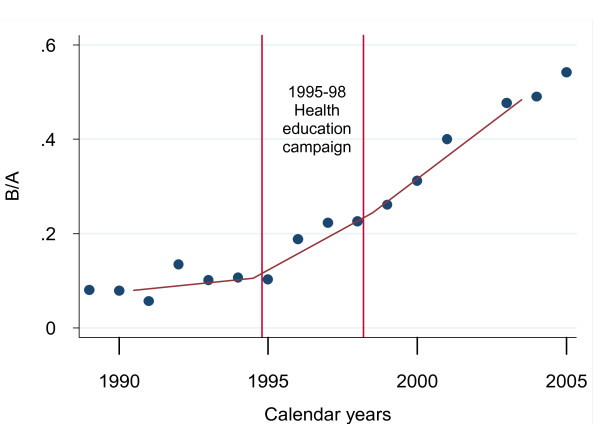
Early maternity leaves allowed by the Provincial Directorate for Work (DPL): B/A§ by years. § “B” includes cases allowed by DPL under Letter b) and c) of Article 17, law 151/2001; “A” includes cases allowed by DPL under Letter a) of Art. 17, law 151/2001